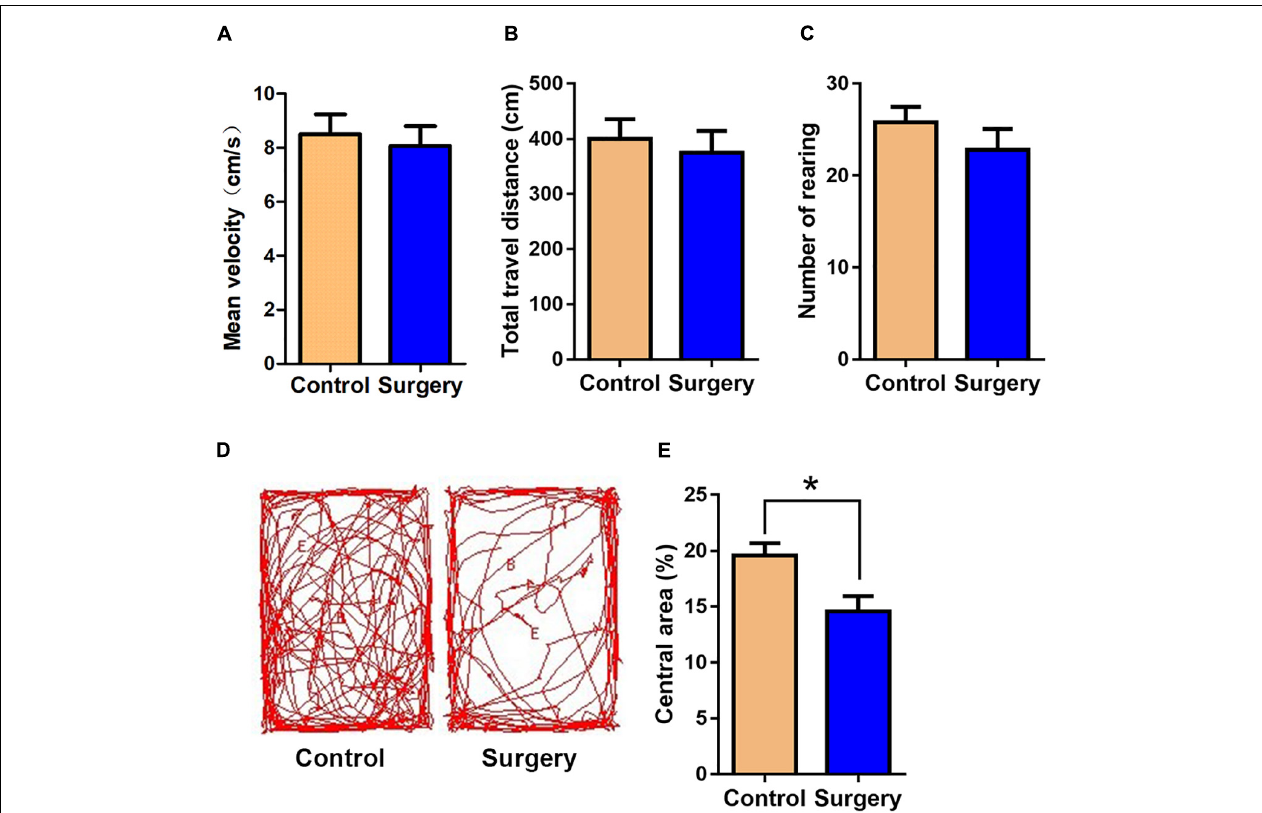
FIGURE 1 | Surgical trauma induces anxiety-like behavior in aged mice. The time in the central area was taken as measures of anxiety and exploratory behavior in the open-field test. (A) Mean velocity. (B) Total travel distance. (C) Rearing activity. (D) Entries into the center. (E) % central area. Data are presented as means ± SEM; ∗ P < 0.05, vs. Control, Student’s t -test, N = 10 for all